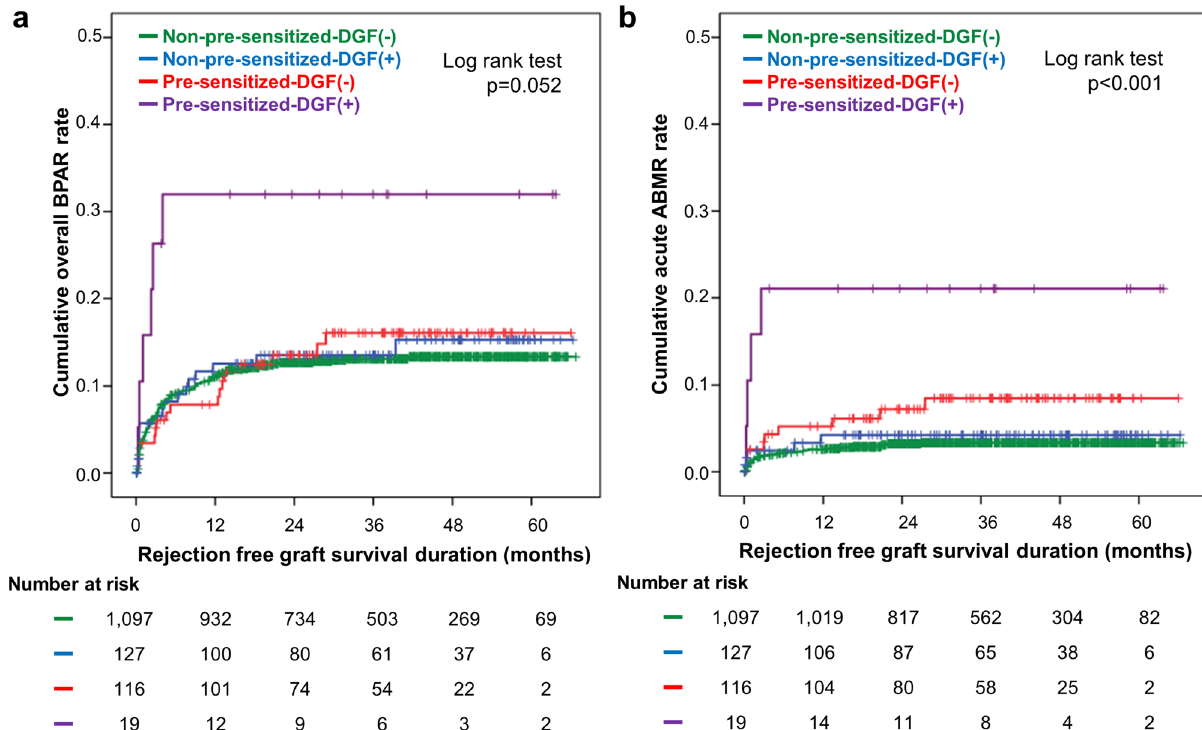
Figure 1. Kaplan–Meier estimates of withdrawal-censored allograft rejection according to DGF and pre- sensitization status. ( a ) Overall BPAR rate, ( b ) acute ABMR rate. The numbers below the figures denote the number of KTRs at risk in each subgroup. DGF delayed graft function, BPAR biopsy-proven allograft rejection, ABMR antibody-mediated rejection, KTR kidney transplantation